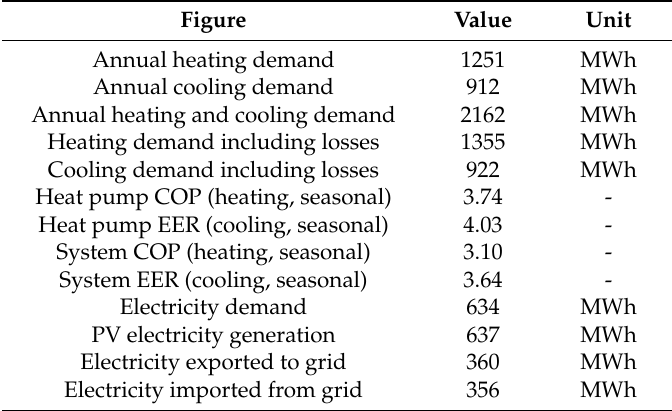
Table 4. Energy performance of the DHC system. Figure